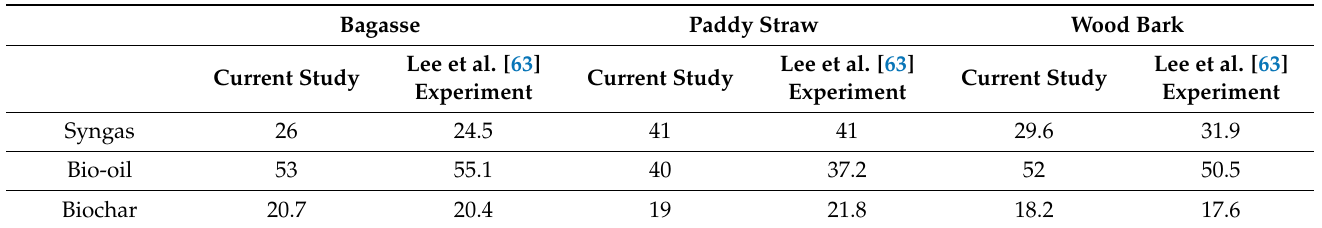
Table 13. Comparison of product yields for bagasse, paddy straw and wood bark